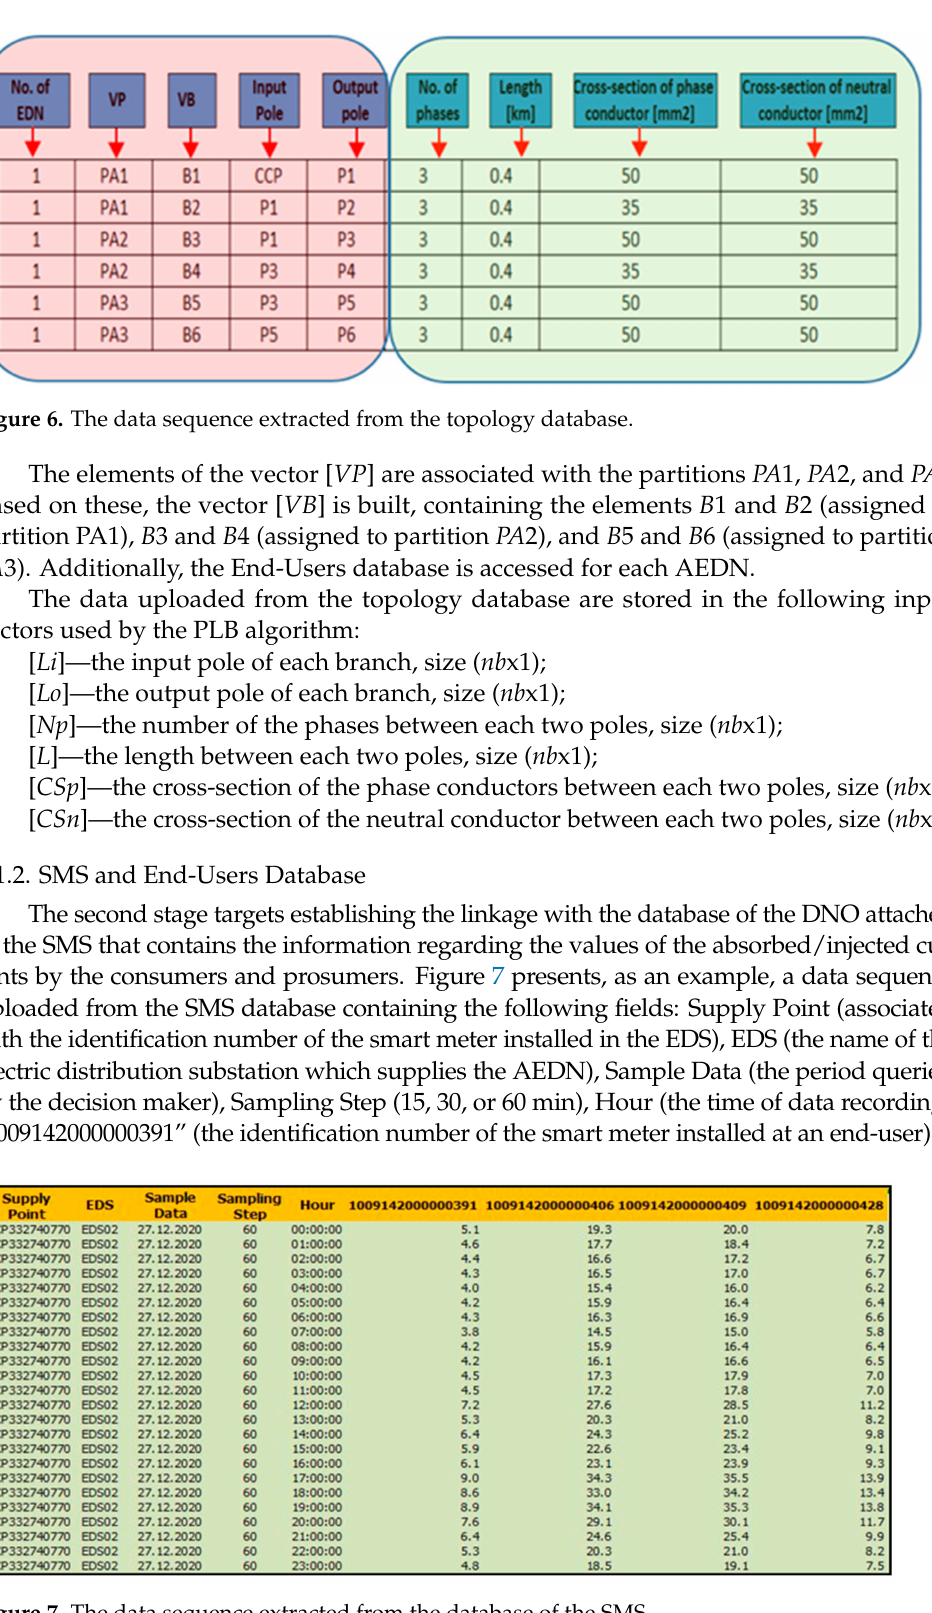
Figure 7. The data sequence extracted from the database of the